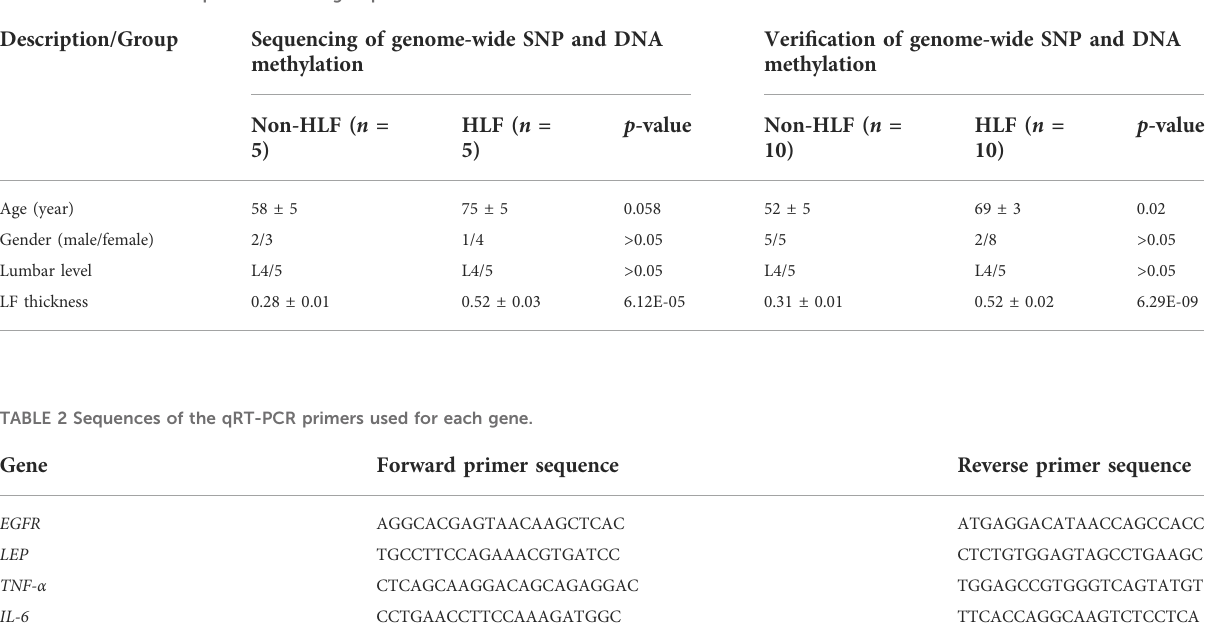
TABLE 1 Clinical data of patients in two groups.